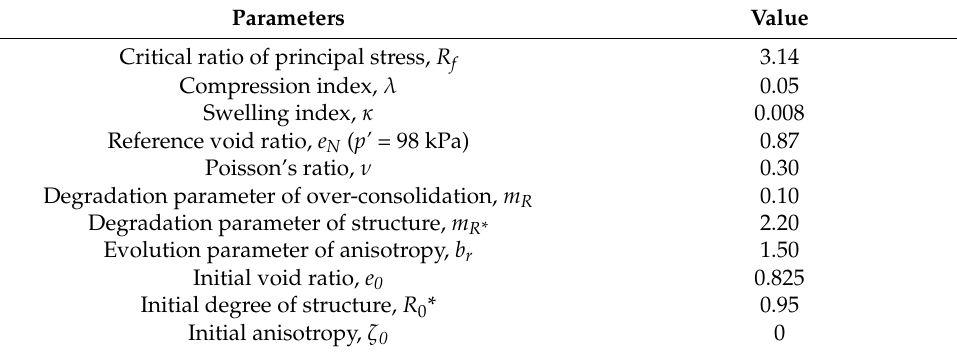
Table 3. Parameters of Toyoura sand in CM model used for calculation.